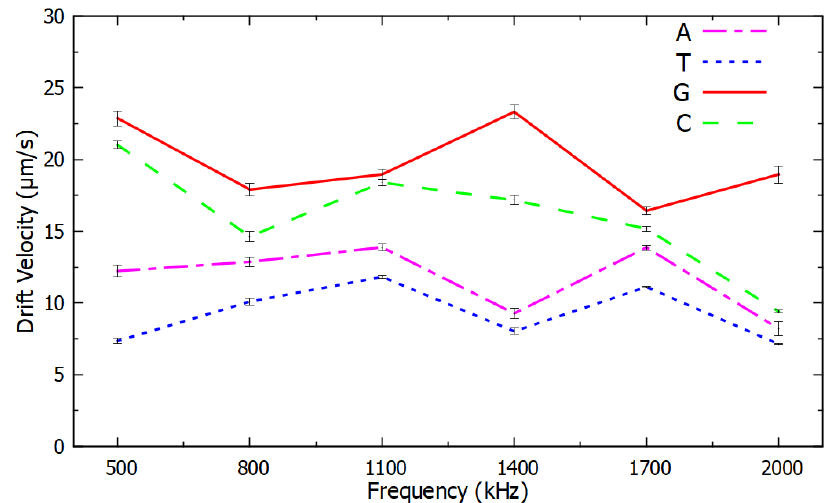
Figure 4. Negative DEP spectra for different nucleotides at the end of ssDNA sequences averaged over six measurements per frequency. All the other nucleotides were the same in the ssDNA sequences. The error bars show the confidence interval of the average value.